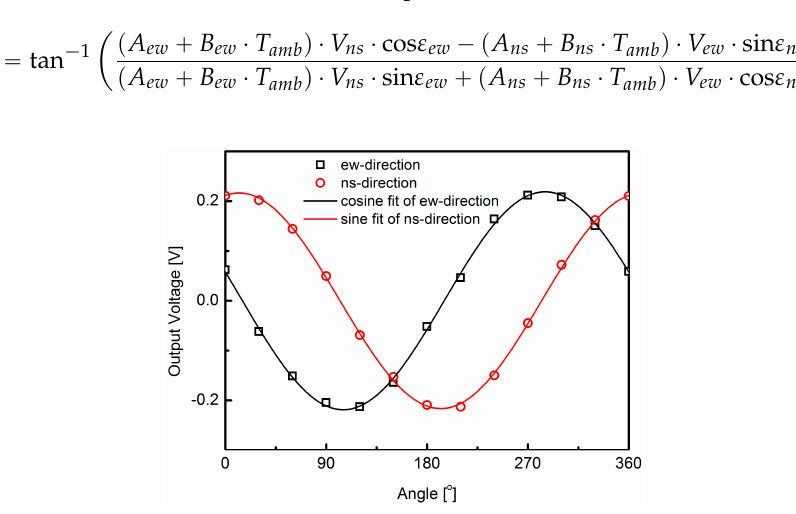
Figure 2. The output voltages in the north-south direction and east-west direction. The wind speed is 7 m/s, and the ambient temperature is 15 °C. According to the fit curves, the constant phase shifts ε ns and ε ew are 77.3° and 76.7°, respectively.